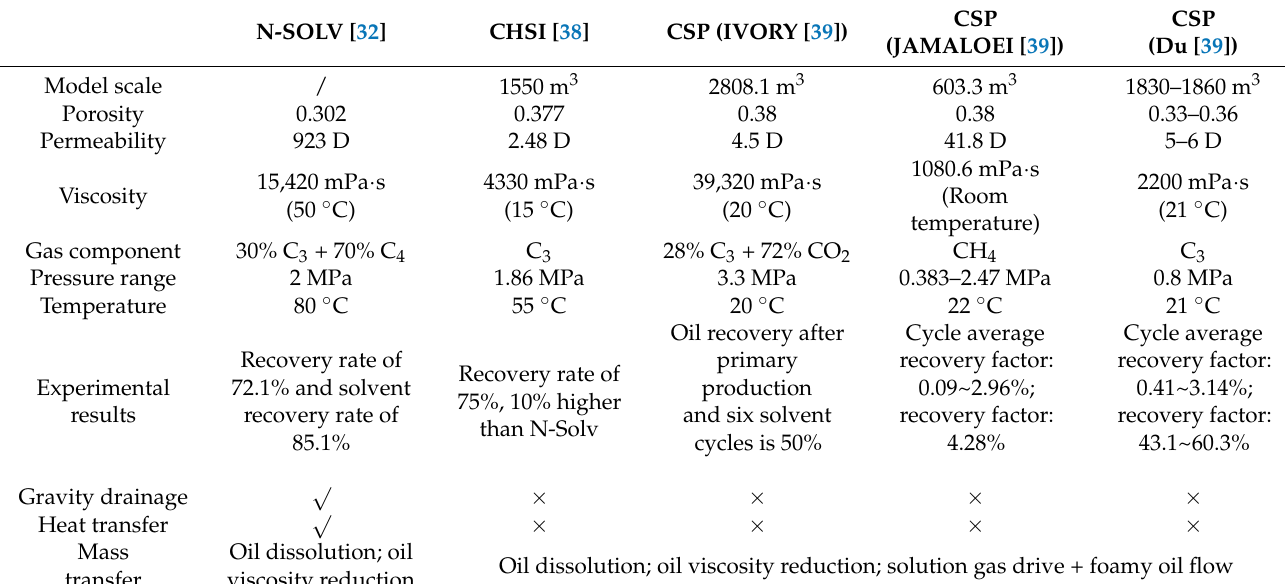
Table 3. Comparison of indoor experimental